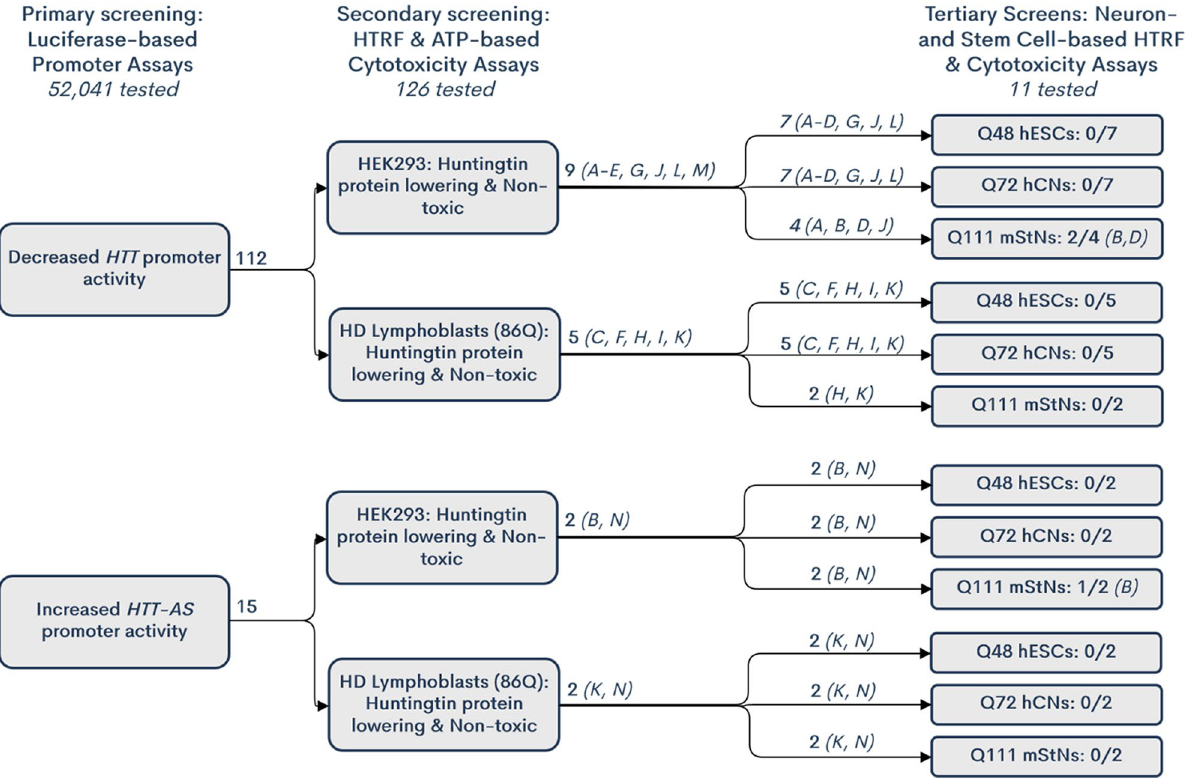
Figure 5. Summary of high throughput screening for HTT and HTT-AS promoter modifiers. 52,041 compounds were tested in the primary screen, with a total of 123 hits (112 hits in the HTT promoter assay and 15 in the HTT-AS promoter assay, with 4 compounds active in both assays. Of these 123 compounds, 14 were identified as huntingtin-lowering and non-toxic in the secondary screen. 10 were found to lower huntingtin protein in HEK293 cells and 6 in HD-patient derived lymphoblasts, with 2 active in both cell types. 12 of these compounds were tested in HD human embryonic stem cells (hESCs) and HD cortical neurons (hCNs), and 8 in immortalized HD mouse striatal neurons (mStNs). Compound IDs (Table 4) in chart indicate which compounds moved forward to each tertiary screen. 2 compounds (NCGC00100369; B) and (NCGC00113437; D) were identified as active in the mStNs, but not in hESCs or